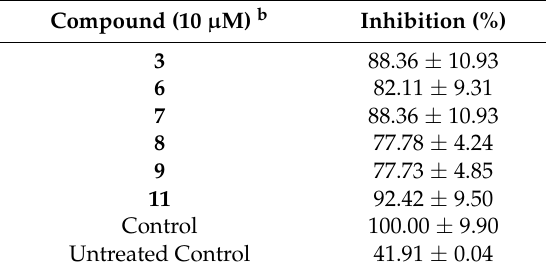
Table 3. Inhibitory effects of the isolated compounds on RANKL-induced osteoclast differentiation.